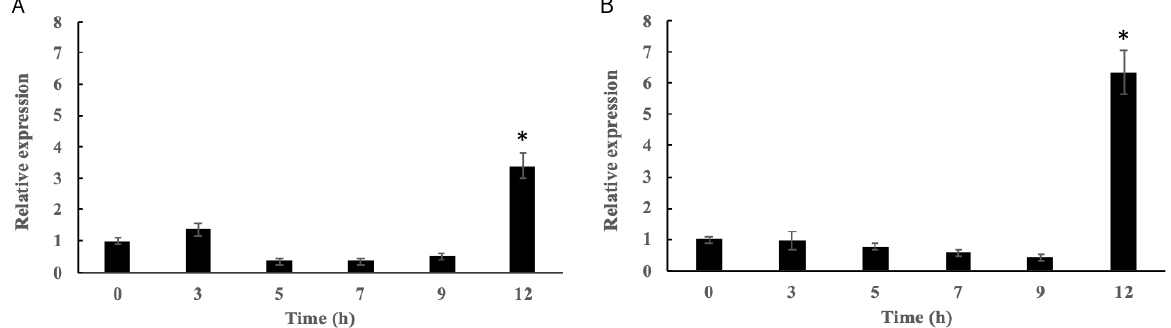
Figure 3. Relative expression of CgCmr1 ( A ) and CgPks1 ( B ) in the wild-type control at different time points. * Significant differences among time points as determined by the t -test ( p < 0.05).